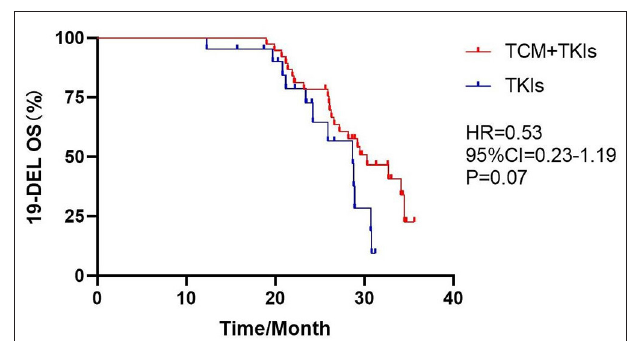
FIGURE 2 | Comparison of 19DEL mPFS by two groups.